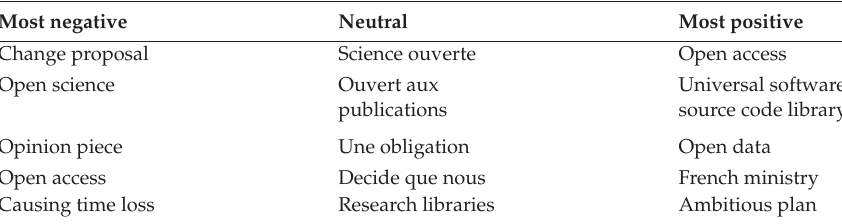
Table 3. Theme’s